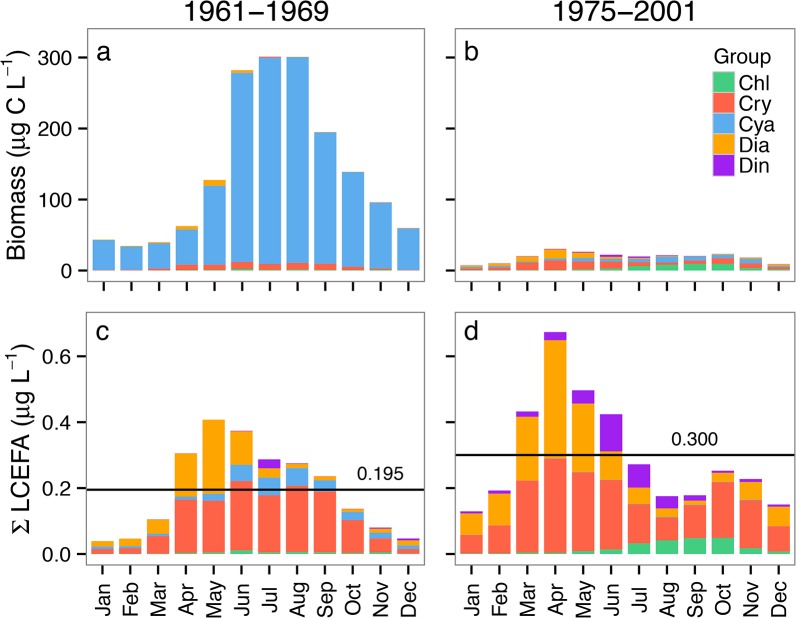
Stacked barplots of observed average monthly phytoplankton biomass (a, b) and calculated LCEFA concentrations (c, d) in Lake Washington.Panels (a) and (c) show the group composition during the eutrophic years (1961–1969), and panels (b) and (d) summarize the oligotrophic years (1975–2001) for biomass and LCEFA, respectively. Group specific LCEFA are calculated following Eq 2. The mean calculated annual LCEFA value across years within each time period is superimposed as a line on panels c and d. Abbreviations follow Fig 1.